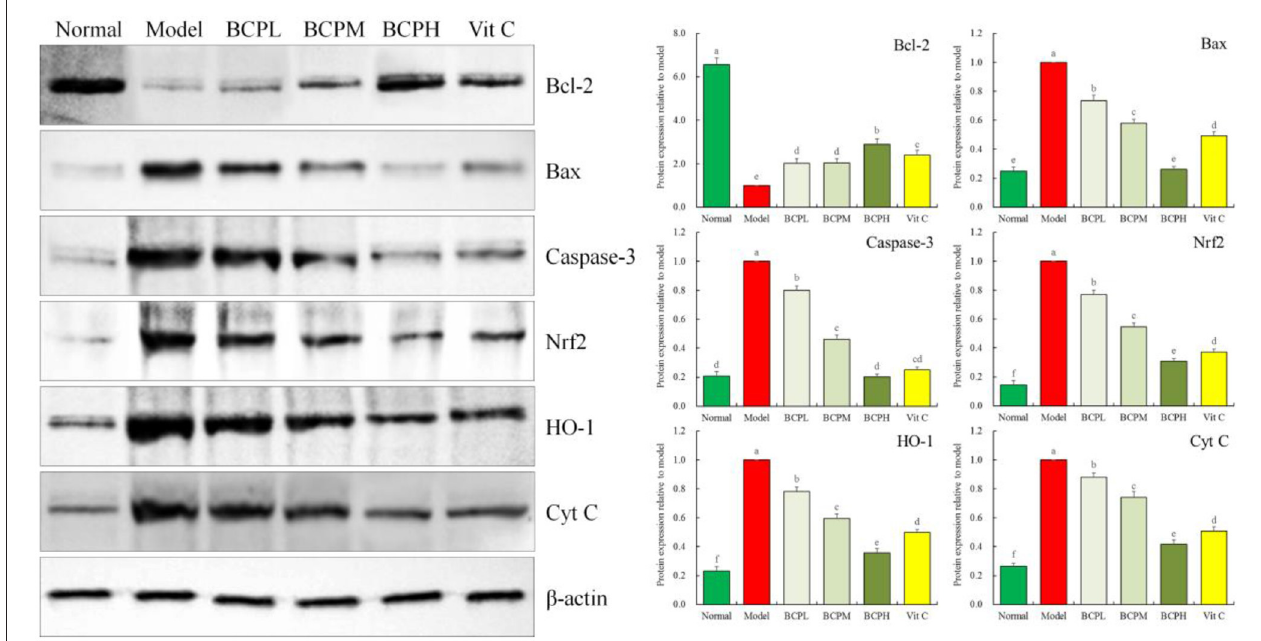
FIGURE 9 | Effect of BCP on protein expressions of Bcl-2, Bax, Casepase-3, Nrf2, HO-1, and Cyt C of H9c2 cells with OS injury. a − f Mean values with different letters over the bar are significantly different ( P < 0.05) according to Tukey’s honestly significant difference.